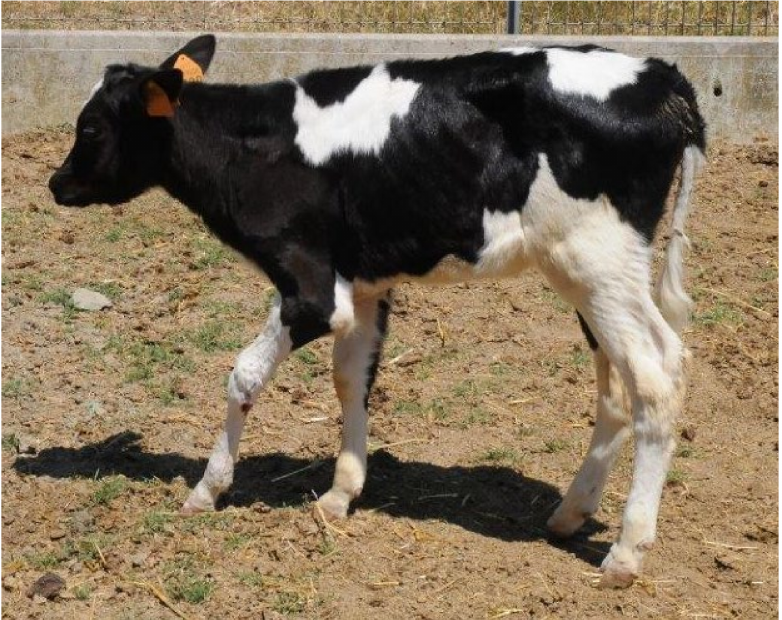
Figure 1. Presentation of the calf at admission. Observe the posture of the left thoracic limb: flexed and dropped elbow, flexed carpus, overextended fetlock